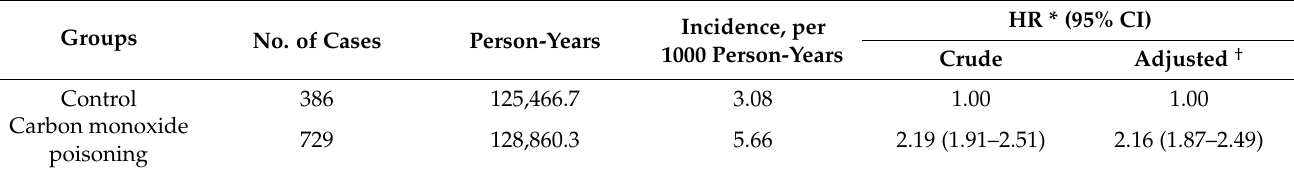
Table 2. Incidence rates and hazard ratios for ischemic heart disease among the CO poisoning and control groups. Groups